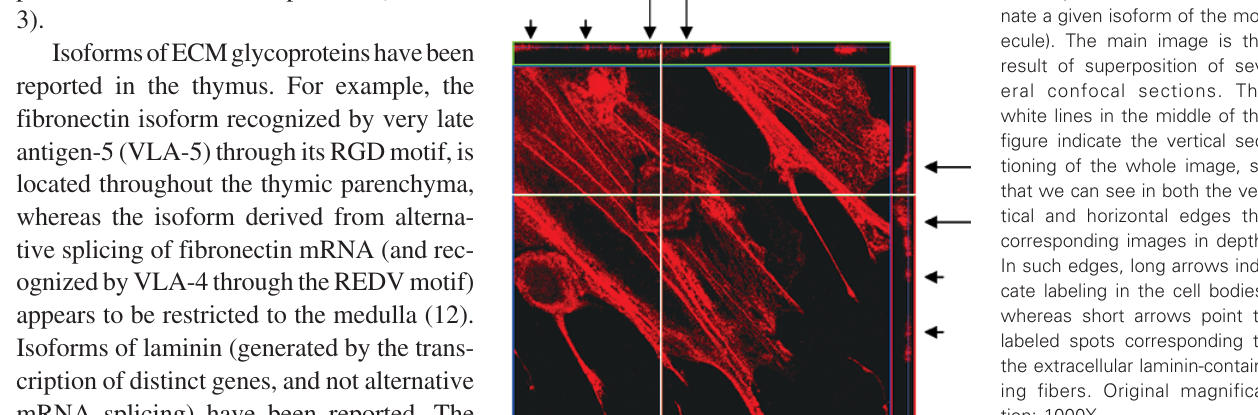
Figure 3. Detection of laminin in thymic nurse cells. In this image obtained by confocal micros- copy, we can see cultured thy- mic nurse cells immunostained with an anti-laminin polyclonal antibody (that does not discrimi- nate a given isoform of the mol- ecule). The main image is the result of superposition of sev- eral confocal sections. The white lines in the middle of the figure indicate the vertical sec- tioning of the whole image, so that we can see in both the ver- tical and horizontal edges the corresponding images in depth. In such edges, long arrows indi- cate labeling in the cell bodies, whereas short arrows point to labeled spots corresponding to the extracellular laminin-contain- ing fibers. Original magnifica- tion: